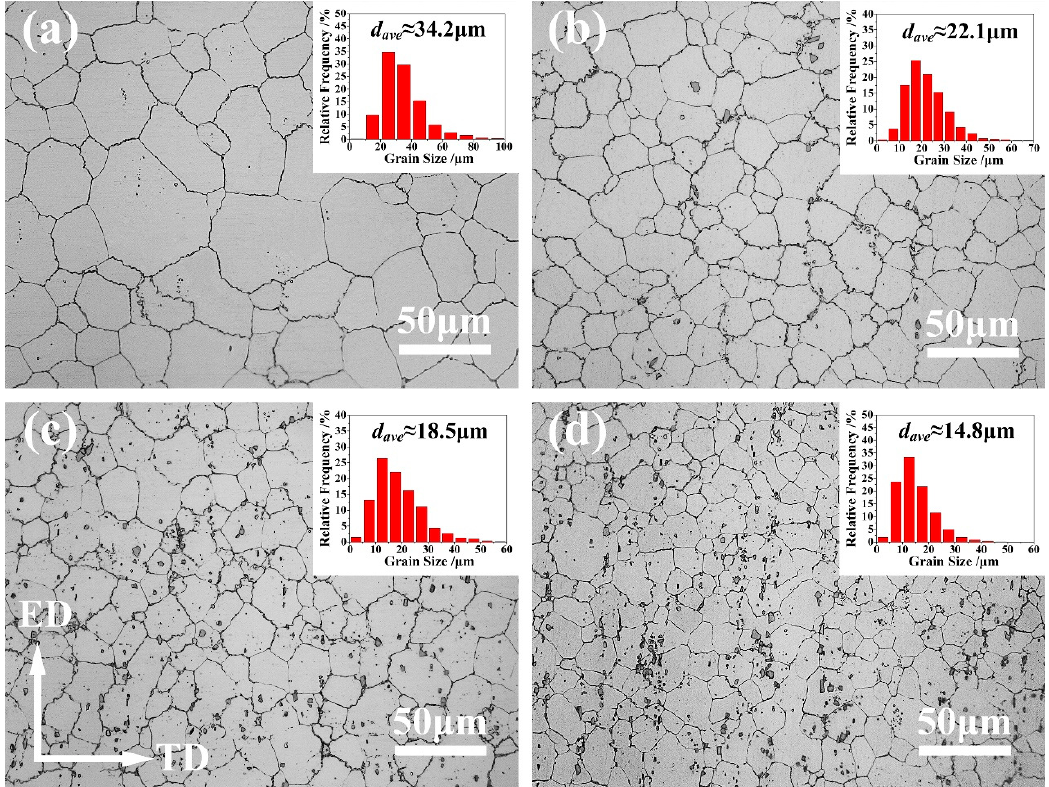
Figure 2. The optical microscope (OM) images and the grain size distribution histograms (inset: d ave stands for the average grain size) of the as-extruded AZ80- x Ce alloys: ( a ) x = 0; ( b ) x = 0.2; ( c ) x = 0.8; ( d ) x = 1.4. ED and TD stand for extrusion direction and transverse direction, respectively.